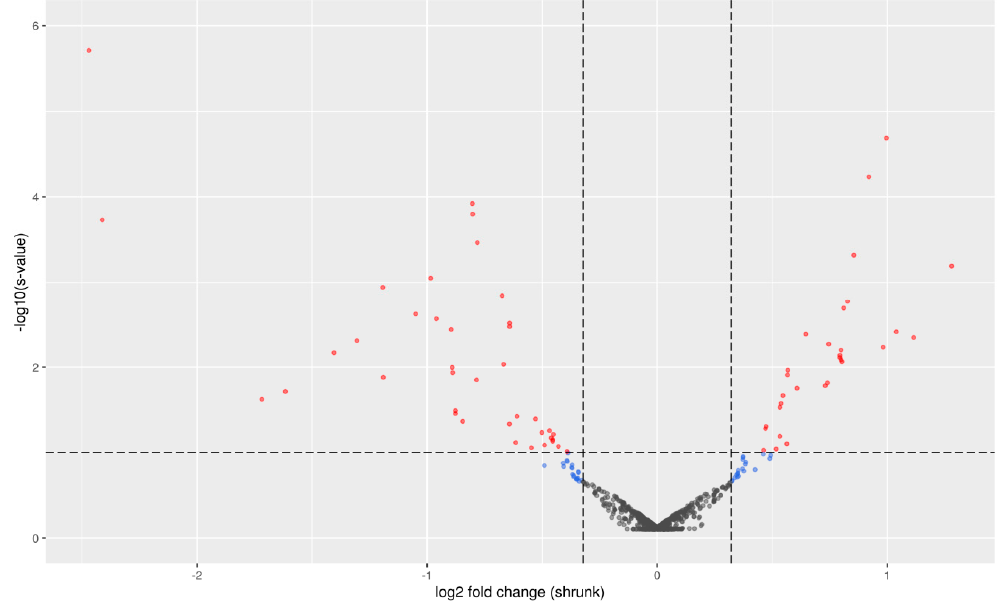
Figure 1. Differential miRNA expression for the phosphorus utilization (PU) group (“high” vs. “low” n = 19): Volcano plot showing −log (cid:2869)(cid:2868) (𝑠) (with 𝑠 denoting the s -values) versus the shrunken log2 fold changes (LFCs; calculated using the “apeglm” method in the function IfcShrink() from R package DESeq2). Red dots denote miRNAs having an s -value below the threshold of 0.10 and an absolute shrunken LFC above the threshold of log (cid:2870) (1.25) ≈ 0.322 . Blue dots denote miRNAs having an s -value above the threshold of 0.10 and an absolute shrunken LFC above the threshold of log (cid:2870) (1.25) ≈ 0.322 . Gray dots denote miRNAs having an s -value above the threshold of 0.10 and an absolute shrunken LFC below the threshold of log (cid:2870) (1.25) ≈ 0.322 . Dashed lines also show the thresholds.